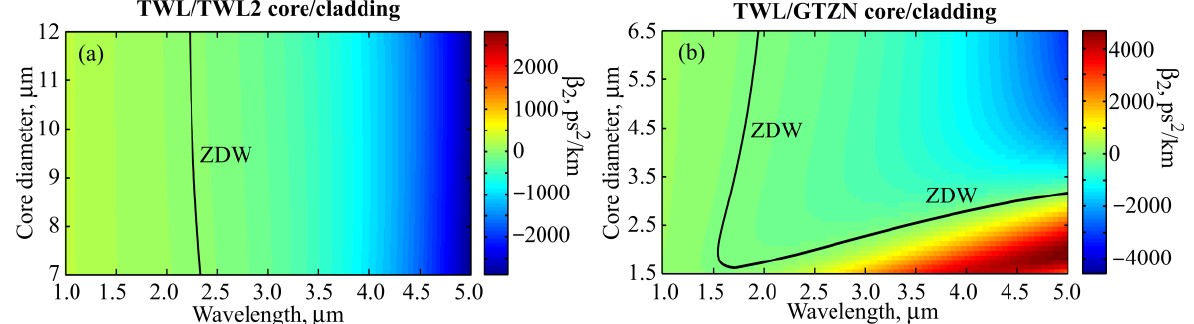
Figure 3. The calculated dispersion for one-core fibers with different core diameters for TWL/TWL2 core/cladding glasses ( a ) and TWL/GTZN core/cladding glasses ( b ).